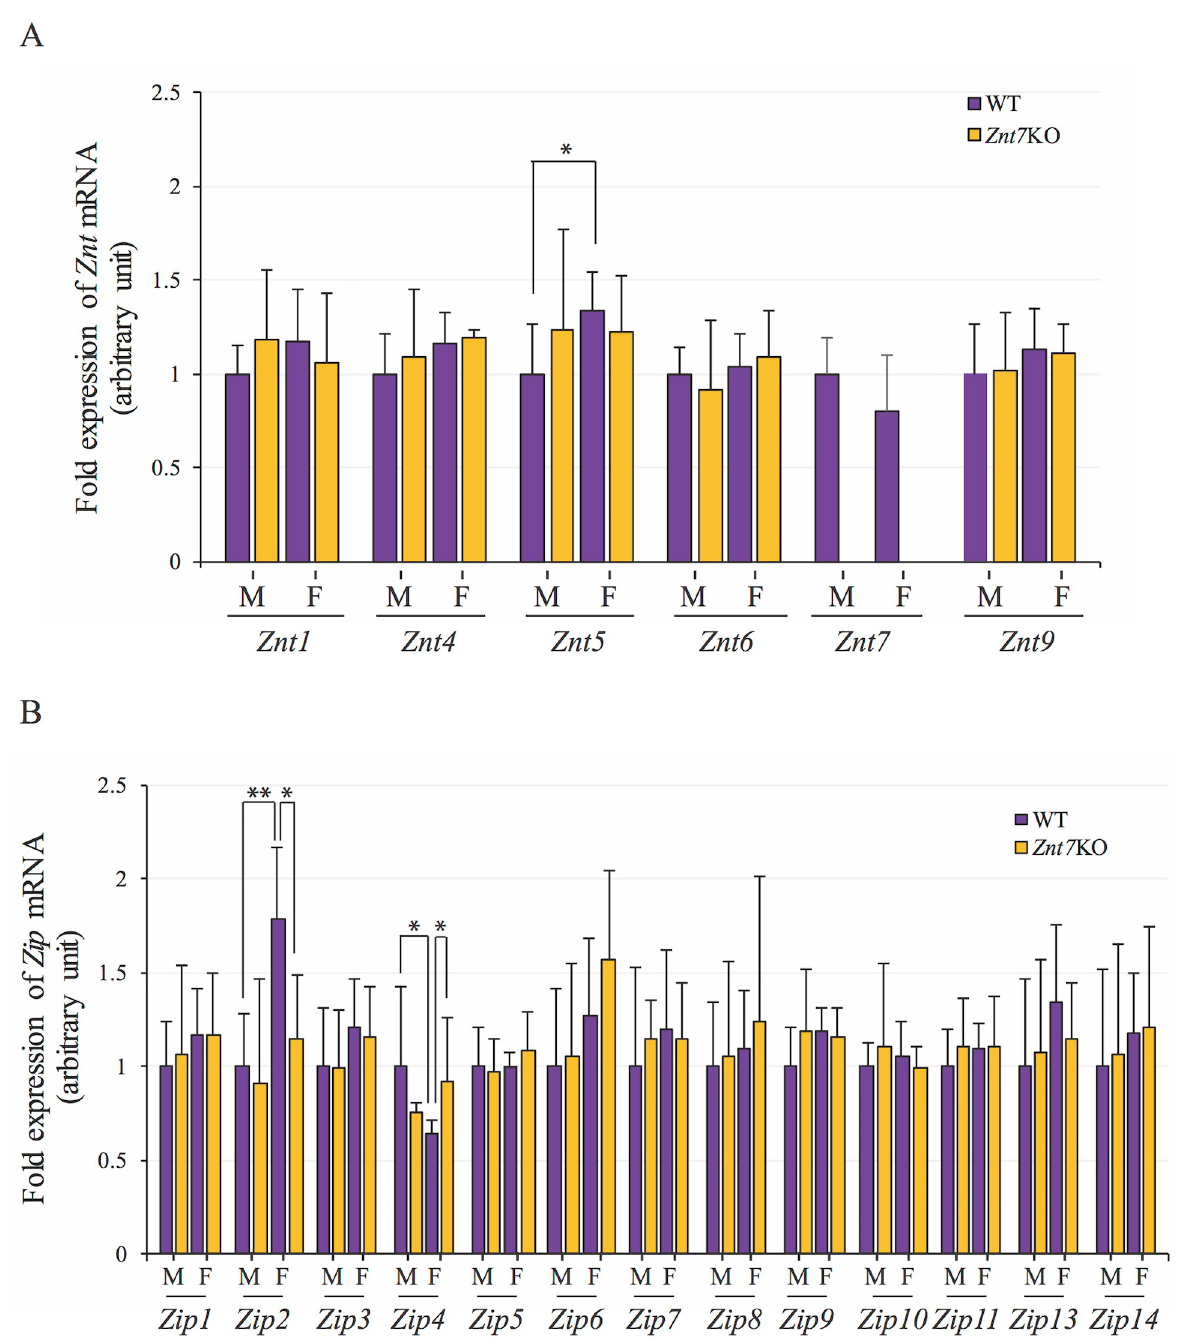
Fig 4. mRNA expression of the Znt and Zip genes in the mouse colon. (A) mRNA expression of the Znt genes 1–10 and (B) mRNA expression of the Zip genes 1–14 in colonic tissue distal to the cecum measured by qRT-PCR. The expression of Actb was used as an internal reference for quantitation of target gene expression using the 2 – ΔΔ Ct method [23]. Values represent the average of technical triplicates for n = 4–5 mice/genotype/ sex. The expression of the target genes was compared to the transcription level in male WT by Student’s t -test. � , p < 0.05; �� , p < 0.01. WT, wild type; Znt7 KO, Znt7